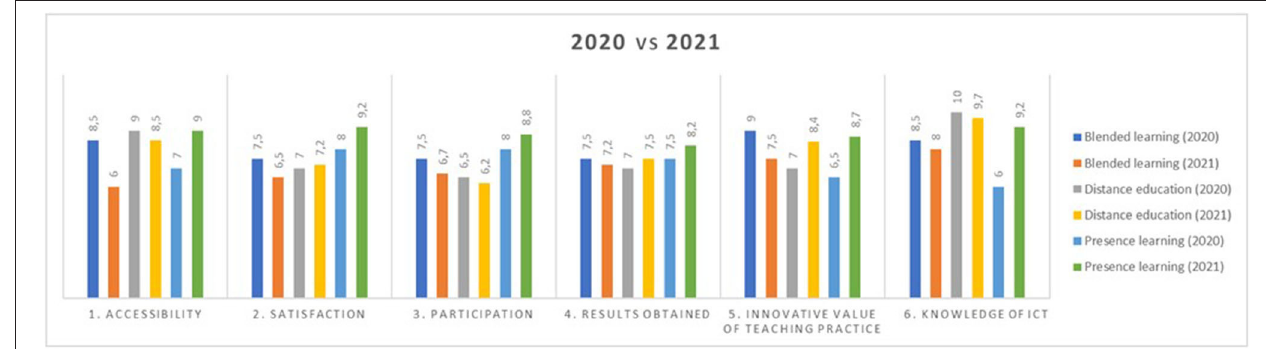
FIGURE 4 | Result of the items studied “Comparative of teachings in bar diagram” in Study 3. Source: Own elaboration.